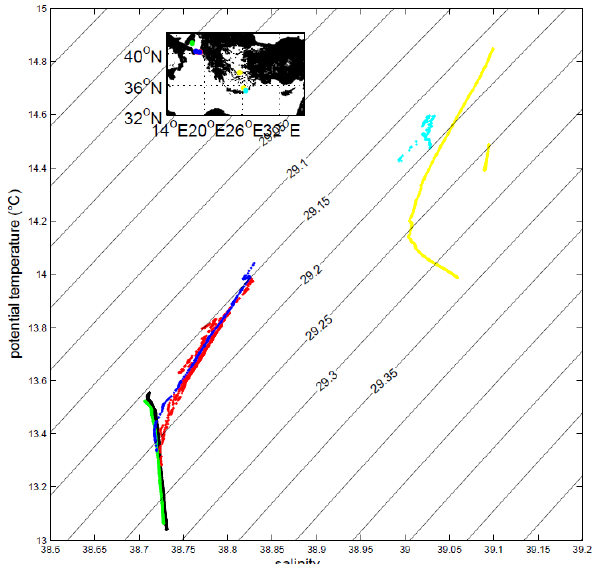
Figure 4. T – S diagram in the areas where dense waters are pro- duced (Aegean and Adriatic Seas). Only values from 600m to bot- tom are considered. Yellow dots: Aegean Sea stations of M84-3. Cyan dots: Kasos Strait station of M84-3. Black dots: Adriatic Pit stations of P414. Green dots: Adriatic Pit stations of M84-3 and red dots: Strait of Otranto, stations of P414. Inset panel shows the location of the different